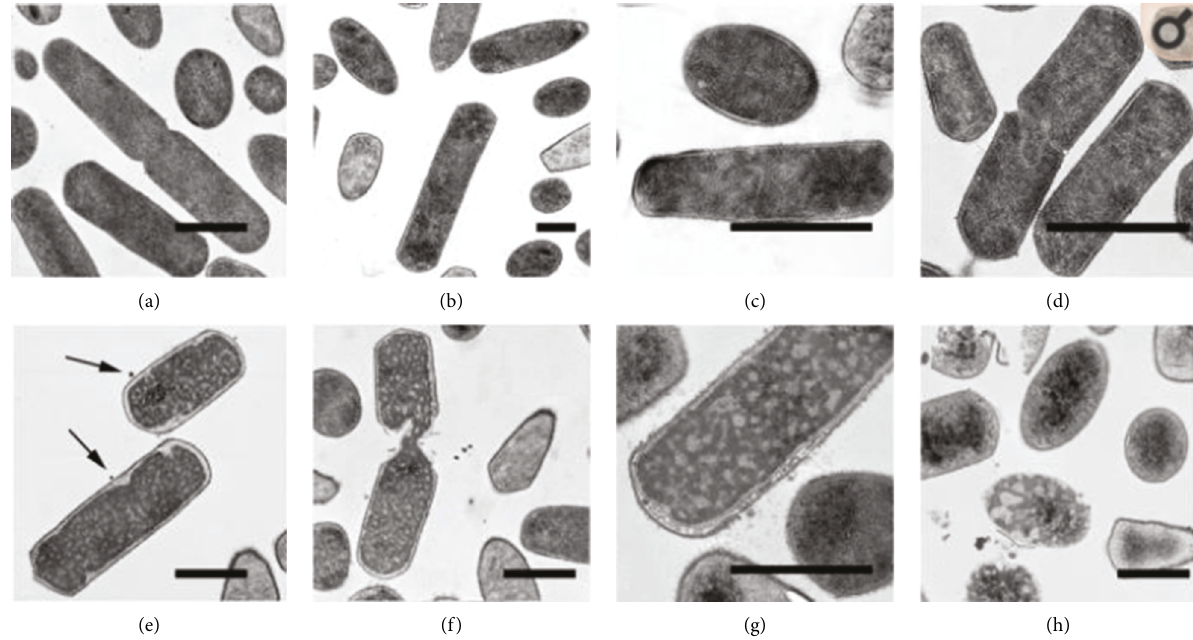
Figure 2: Transmission electron microscopy of C. perfringens cells incubated with synthetic AvBD-6. Bacteria incubated in a minimual medium for 30min were undamaged. In contrast, bacteria incubated for 30min with an increasing concentration of sAvBD-6 exhibited dose-dependent changes in the ultrastructure (a). Granulation of the intracellular material was already observed at 1.56 μ m/ml (b). Irregular septum formation in dividing cells was observed at 1.56 μ m/ml (c) and 6.25 μ m/ml (d). At 12.5 and 25 μ m/ml, cells exhibited retracting cytoplasm (e), lysis at the septa of dividing cells (f), cytoplasmic membrane degradation (g), and complete cell lysis (h)